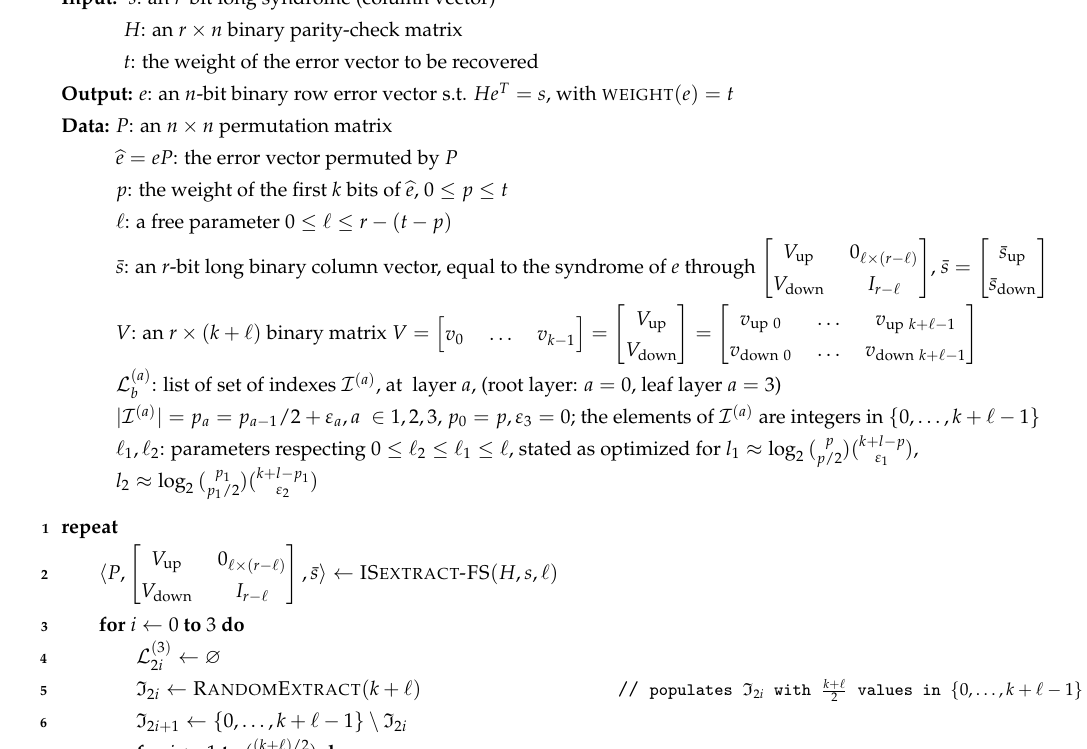
Algorithm 8: Syndrome decoding formulation of Becker–Joux–May–Meurer